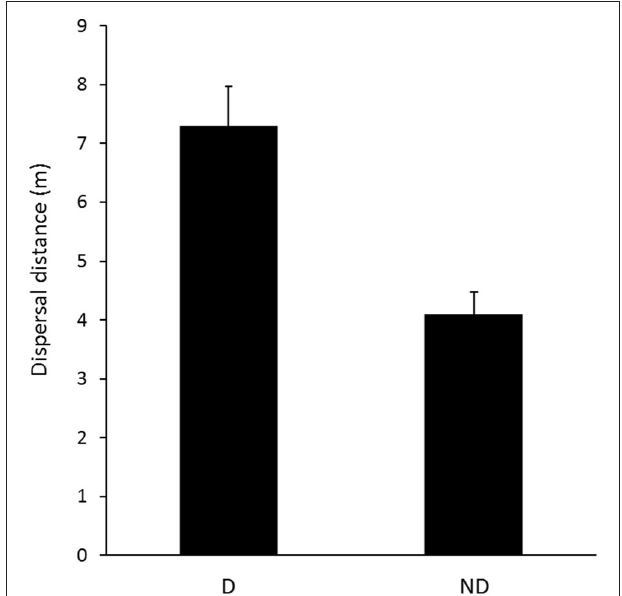
FIGURE 5 | Mean secondary dispersal distances performed by I. purpureus colonies between disturbed (D; n = 111) and non-disturbed (ND; n = 169) zones in the Lockhart Shire. Error bars represent standard error of the mean.